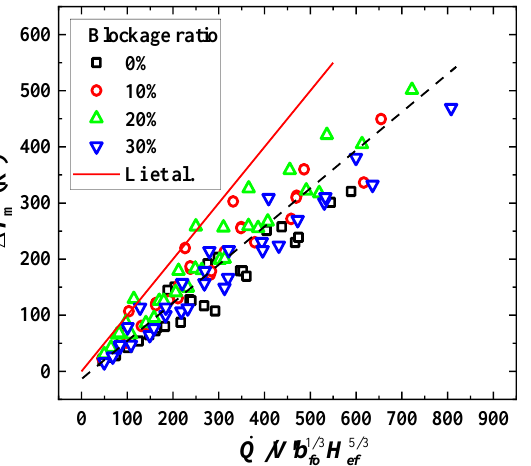
Figure 11. Comparison of the maximum temperature rise with the prediction equation of Li. Equation (6) focuses on the maximum temperature rise of the single-pipe tunnel. To